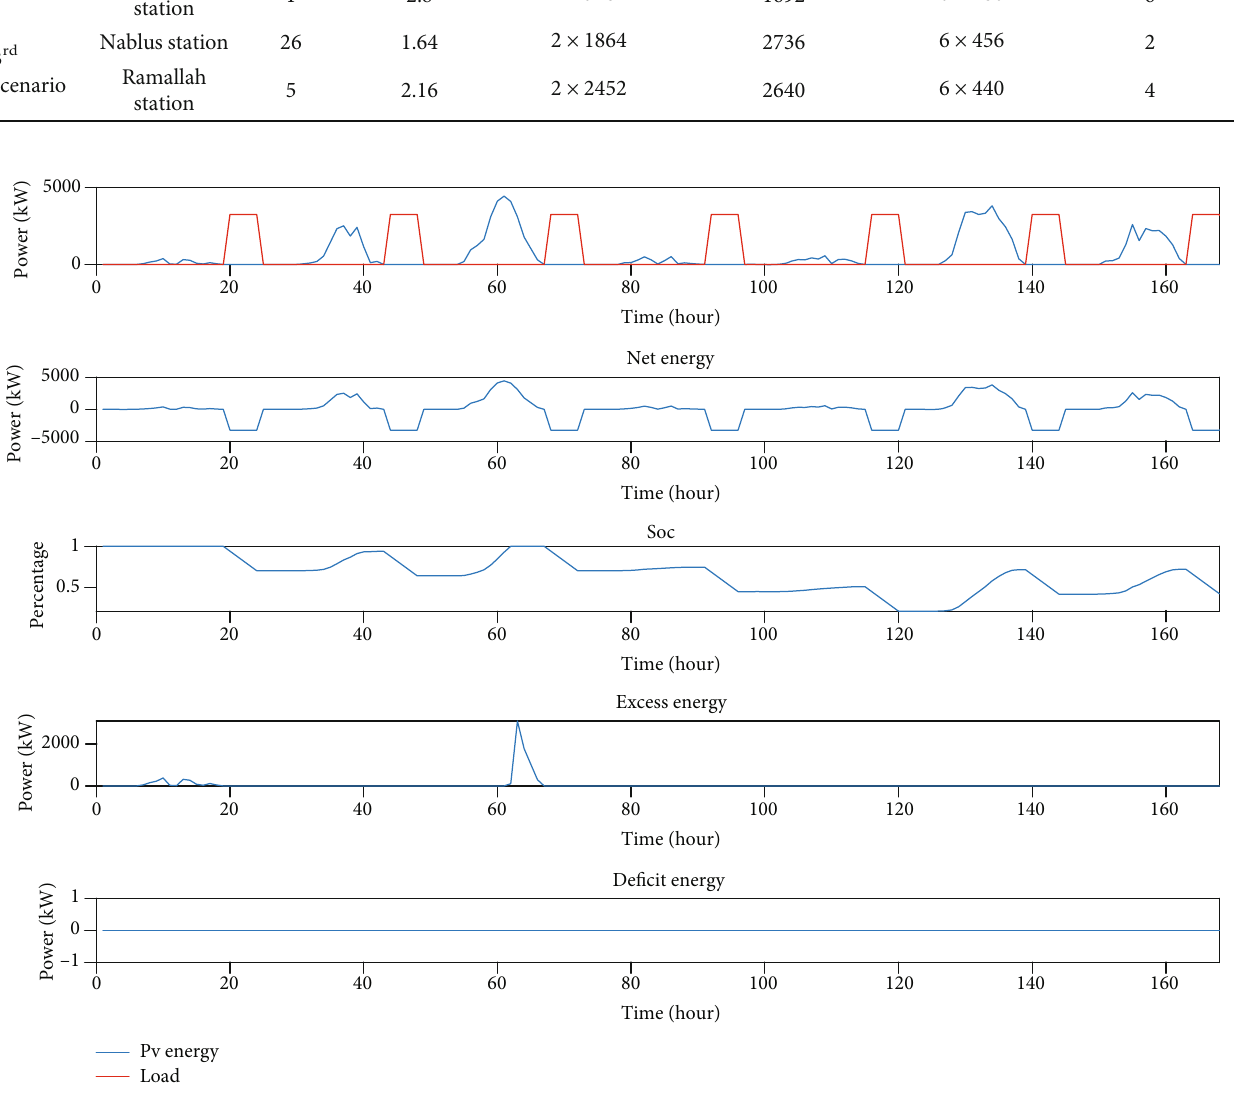
Figure 11: System performance sample for the fi rst scenario: Nablus